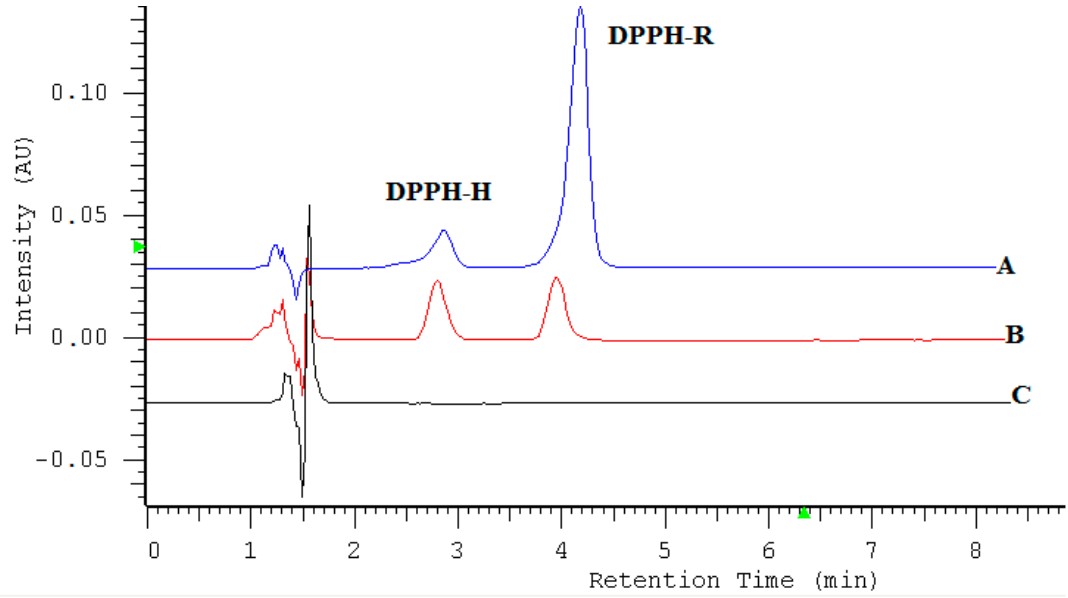
Figure 8. Chromatograms obtained by RP-HPLC-UV at 517 nm. ( A ) 1 mL 0.7 mM DPPH-R + 1 mL methanol; ( B ) 1 mL DPPH-R (0.7 mM) + 500 µL extract (III) + 500 µL methanol after 15 min in the dark place; ( C ) A. podagraria extract III 500 µL + 1.5 mL methanol.